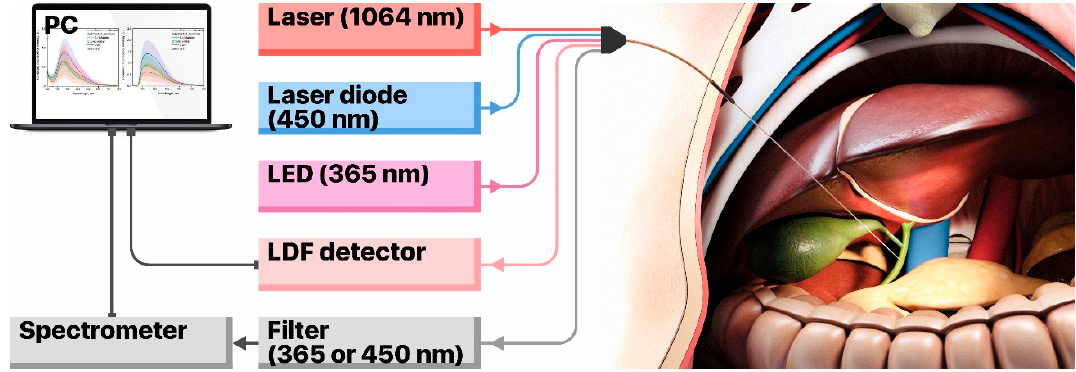
Figure 2. The components of measuring setup and probe placement in the region of interest.